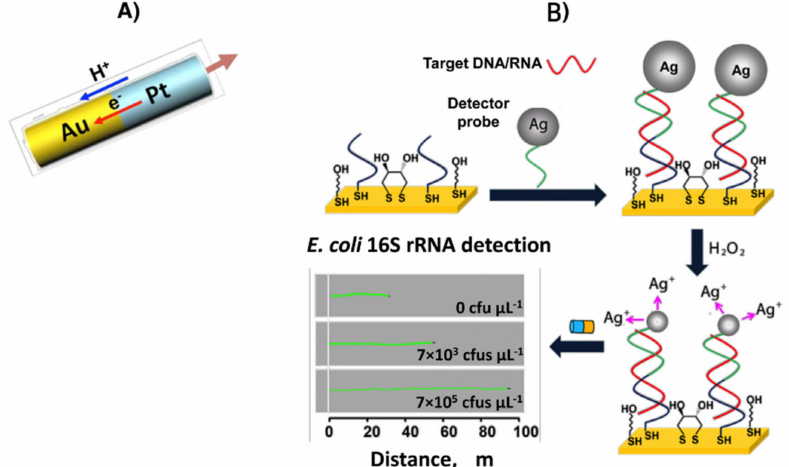
Figure 18. Pt-Au bisegment nanowires ( A ). Basis of the methodology developed for nucleic acid determination and visual detection of the movement of catalytic nanomotors in the resulting Ag + enriched H 2 O 2 solutions after hybridization with the complementary nucleic acid ( B ). Reprinted with permission from ref. [209]. Copyright © 2010, Nature Publishing